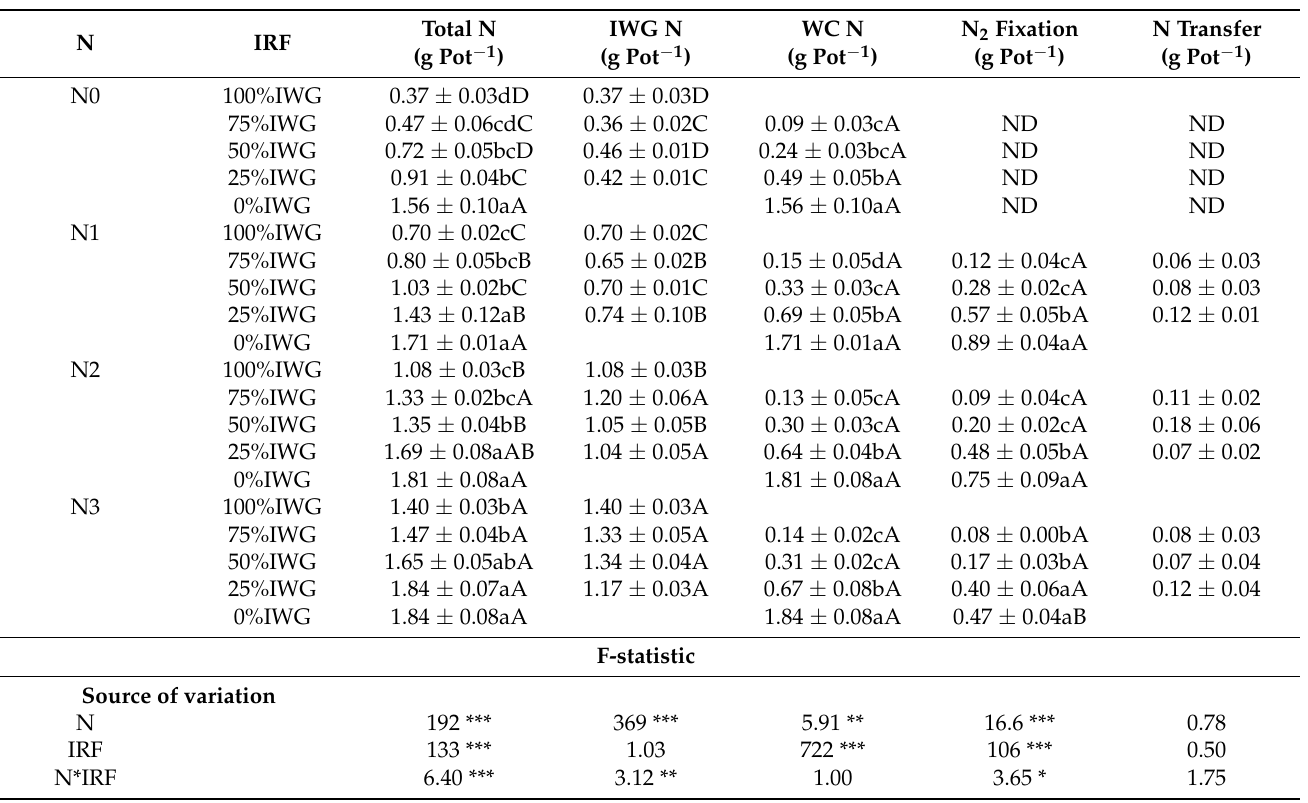
Table 3. The amount of total N accumulation per pot (Total N), N accumulation of intermediate wheatgrass (IWG N) and white clover whole plants (WC N), N 2 fixation of WC, and apparent transfer of N to IWG under five relative frequencies of IWG (IRF) and four N fertilizer levels (N). Data are presented as mean ± standard error. F-statistics and significance from ANOVA are reported below the treatment